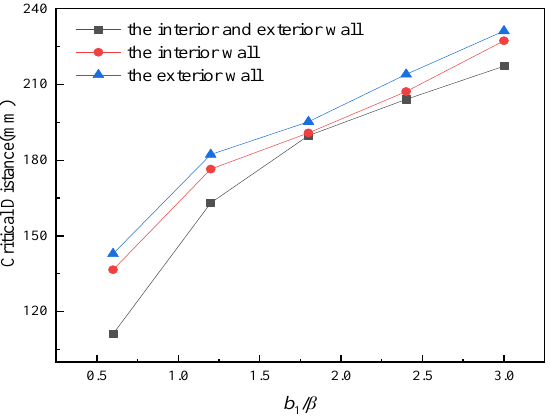
Figure 9. Comparative analysis of the critical distance of defect length.